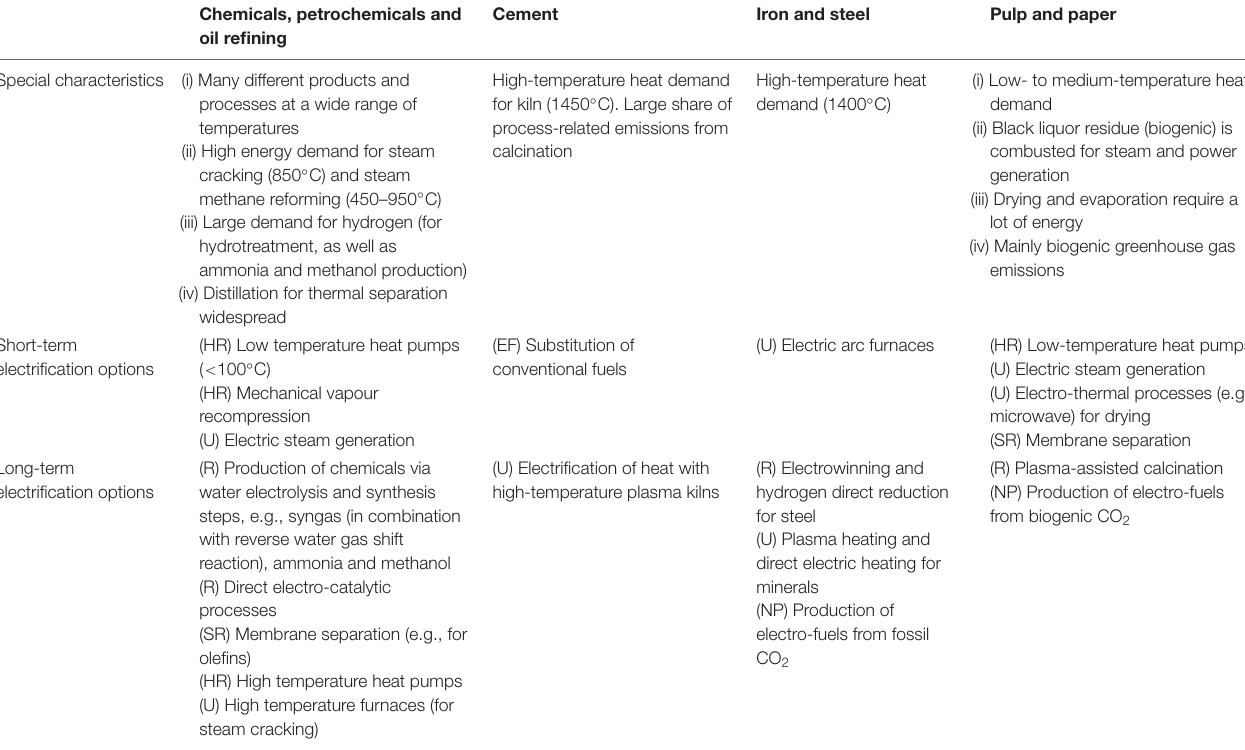
TABLE 1 | Electrification options on different time scales for energy-intensive industries. Chemicals, petrochemicals and Cement Iron and steel Pulp and oil refining